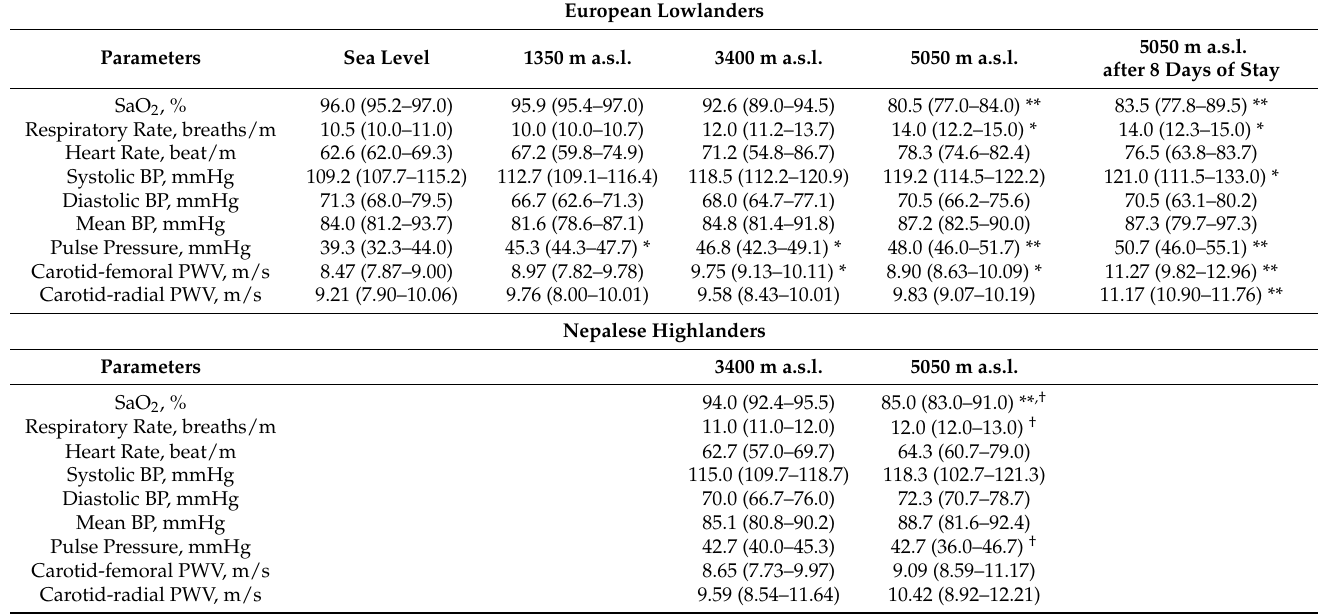
Table 2. Clinical and haemodynamic parameters changes with altitude in lowlander European volunteers ( n = 8) and in highlander Nepalese porters ( n =